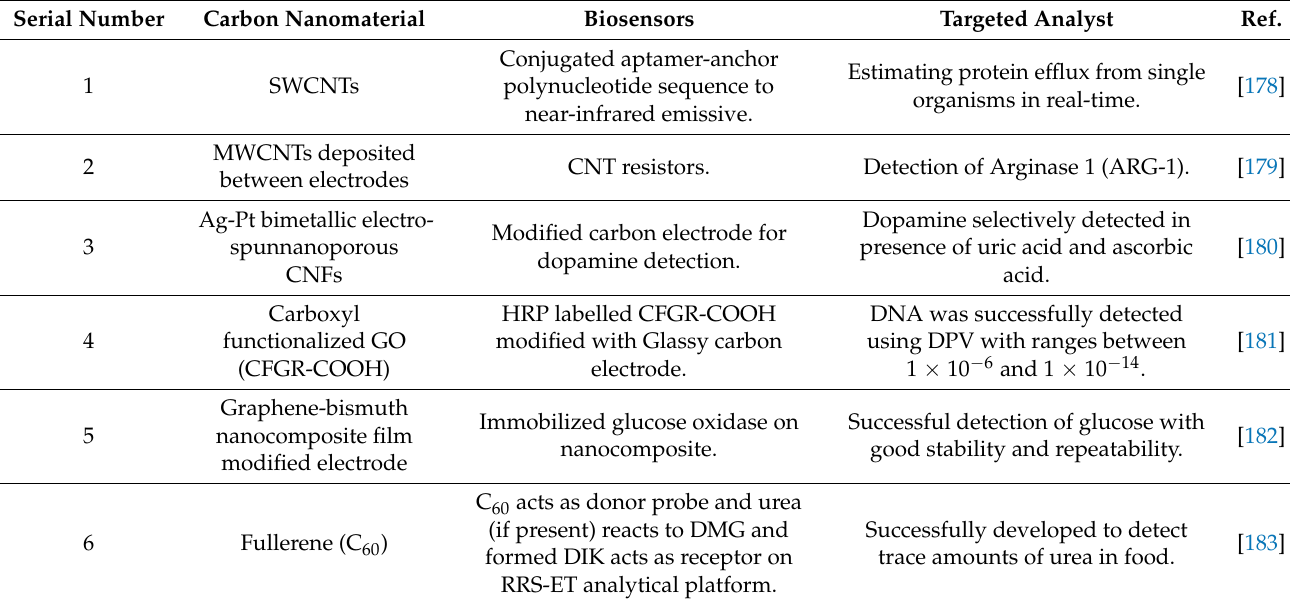
Table 6. Different uses of CNMs in biosensing